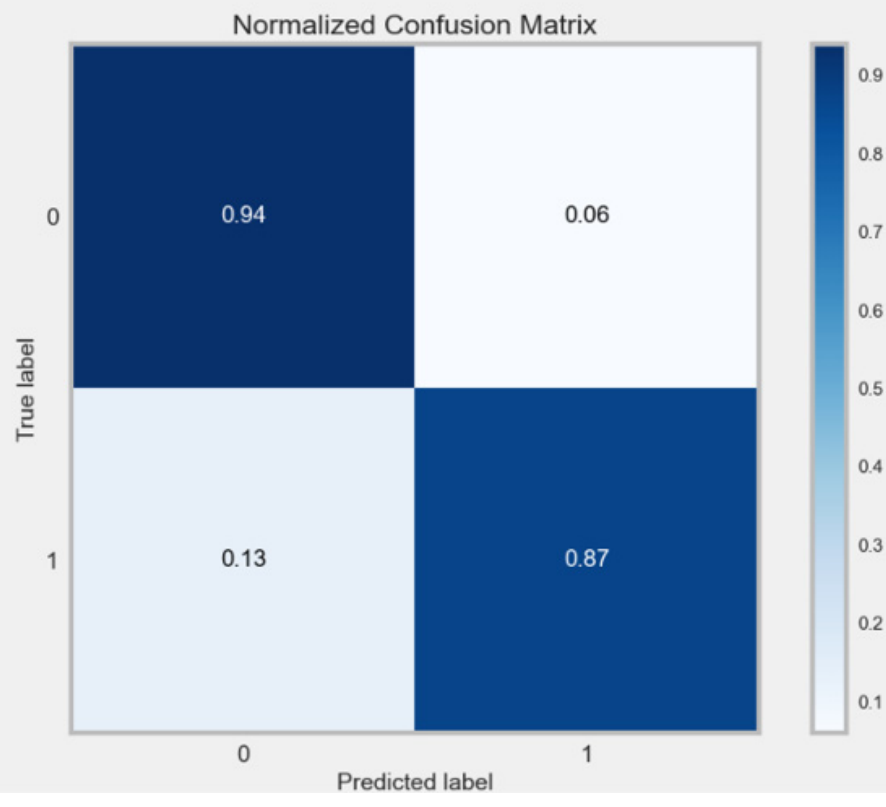
Figure 16. ROC Curves for XGBoost model.